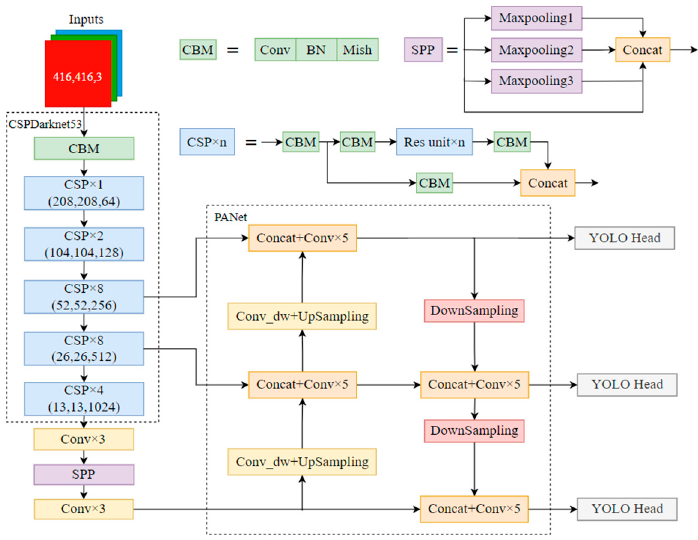
Figure 1. Structure of the YOLOv4 model.